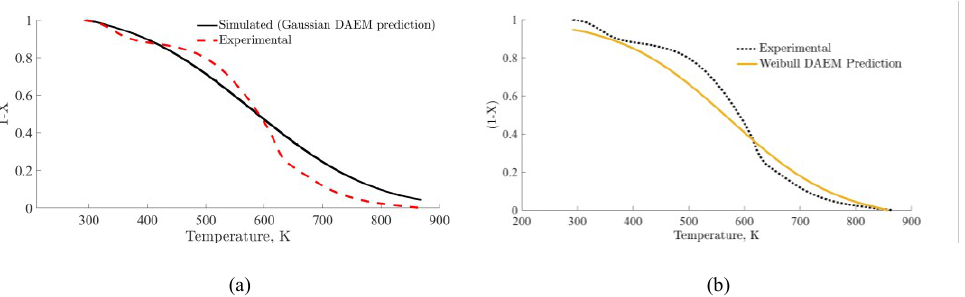
Fig. 8. Comparison between experimental data and the n th order DAEM prediction (Univariate scheme): (a) Gaussian; (b)